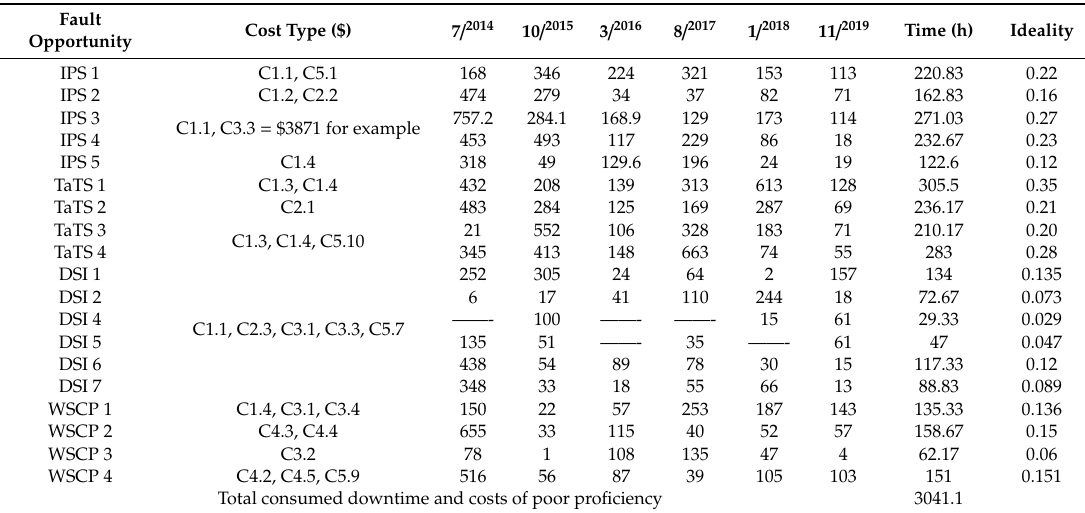
Table 14. Recording the downtimes of violating the LSPL instructions and its related